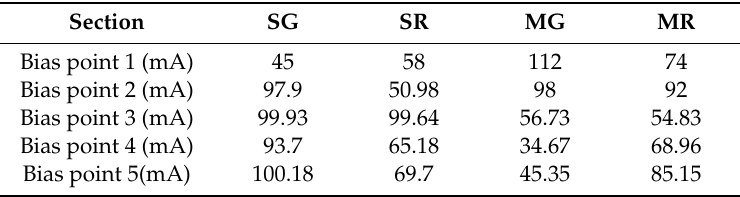
Table 3. Bias points for linewidth measurements.